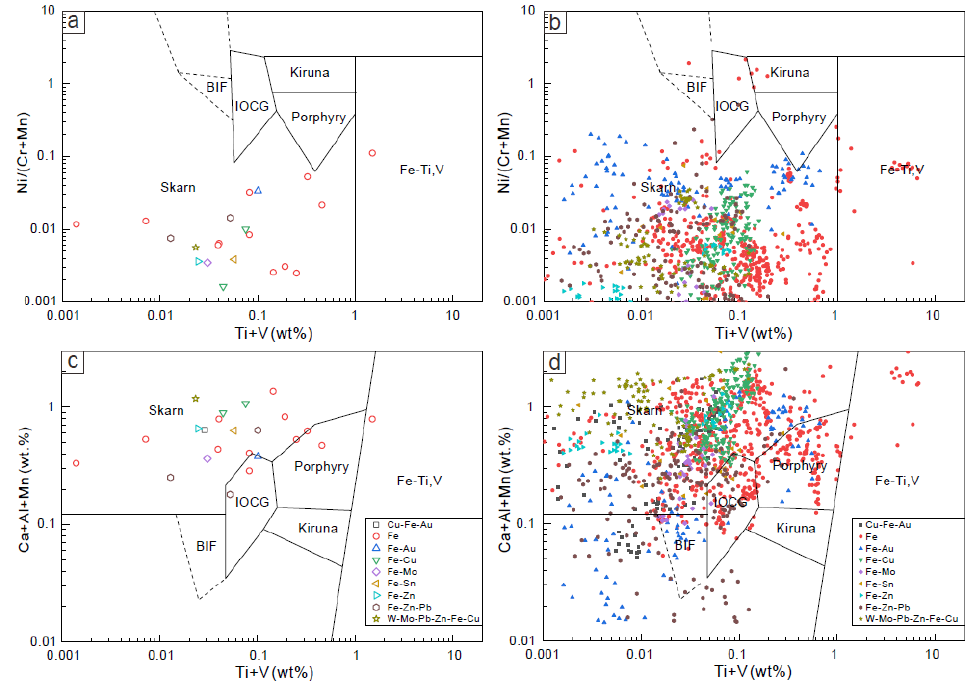
Figure 9. Plot of the average LA-ICP-MS content ( a , c ) and individual analyses ( b , d ) of magnetite in the Ti+V vs. Ni/(Cr+Mn) and Ti+V vs. Ca+Al+Mn diagrams proposed by Dupuis and Beaudoin (2011) [5]. The abbreviations are the same as those in Figure 8.